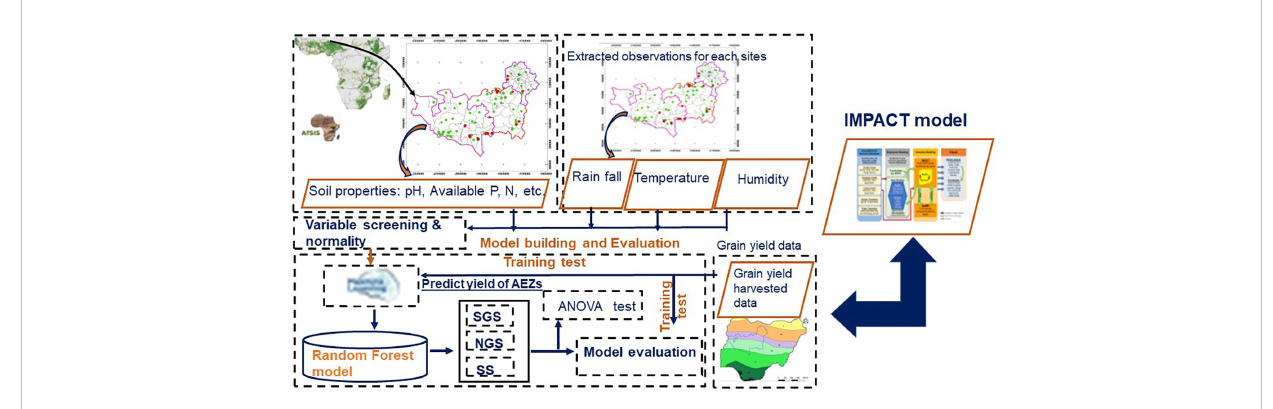
FIGURE 2 Framework of the model implementation approach. ANOVA, Analysis of variance; SGS, southern Guinea Savanna; NGS, northen Guinea Savanna; SS, Sudan Savanna; AEZs, Agroecological